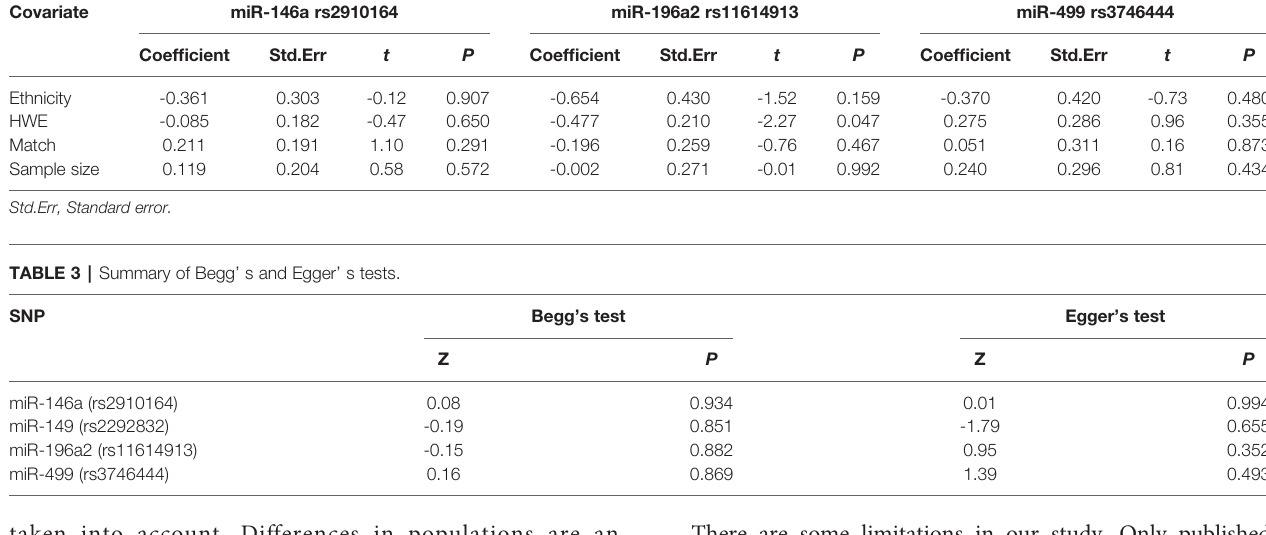
TABLE 2 | Summary of meta-regression analyses for heterogeneity ascertainment. Covariate